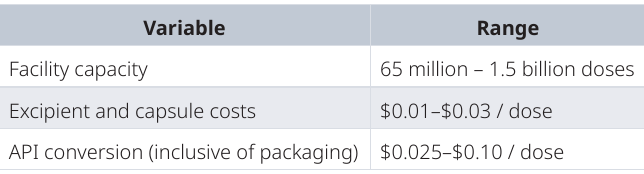
Table 1. Variables and associated costs for the final dosage form of